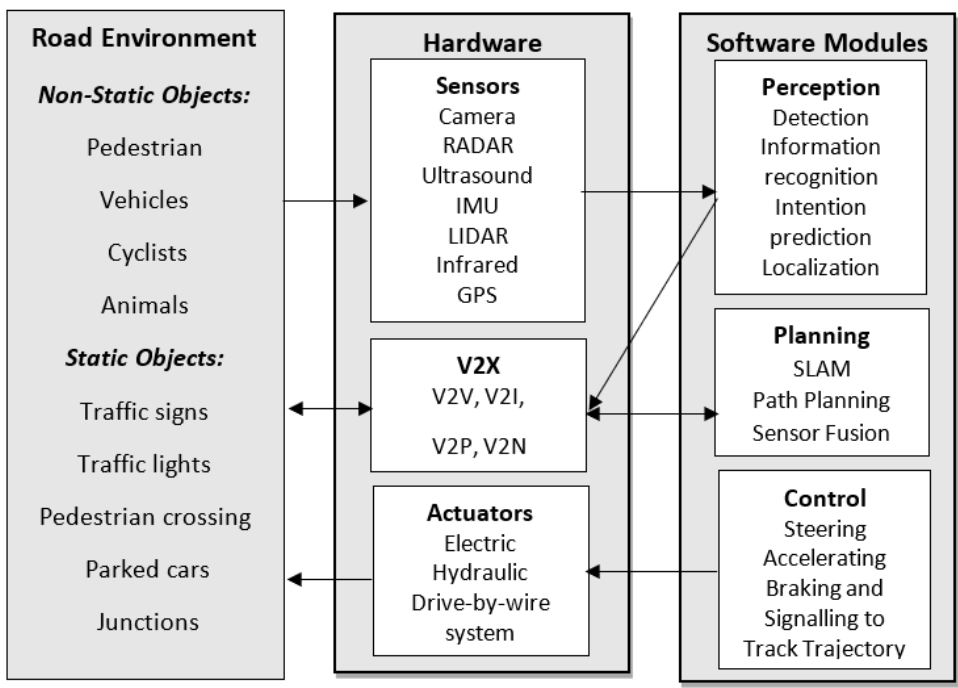
Figure 1. AV architecture: hardware requirements are sensors, V2X communication device and actuators. Software modules are perception, planning and control